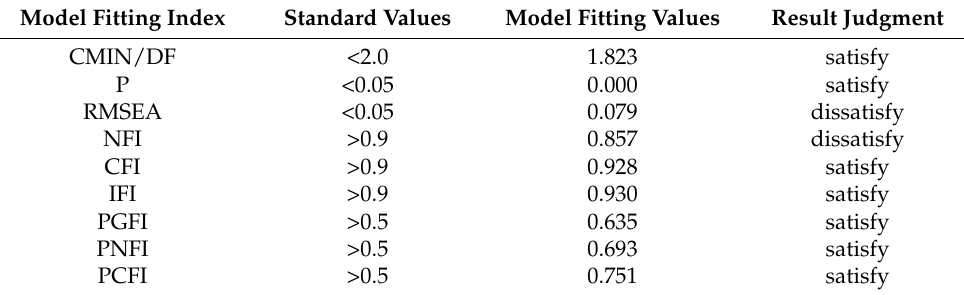
Table 4. Fitting results of structural equation model.